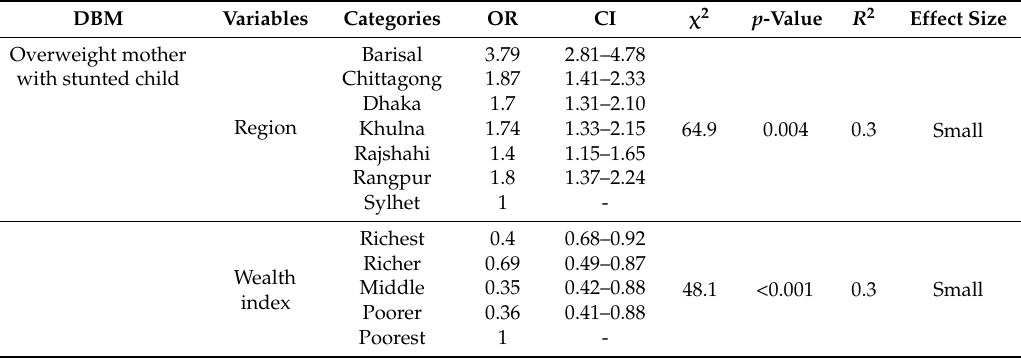
Table 2. Sequential multinomial logistic regression analysis of overweight mother and stunted child pairs by socio-demographic variables.